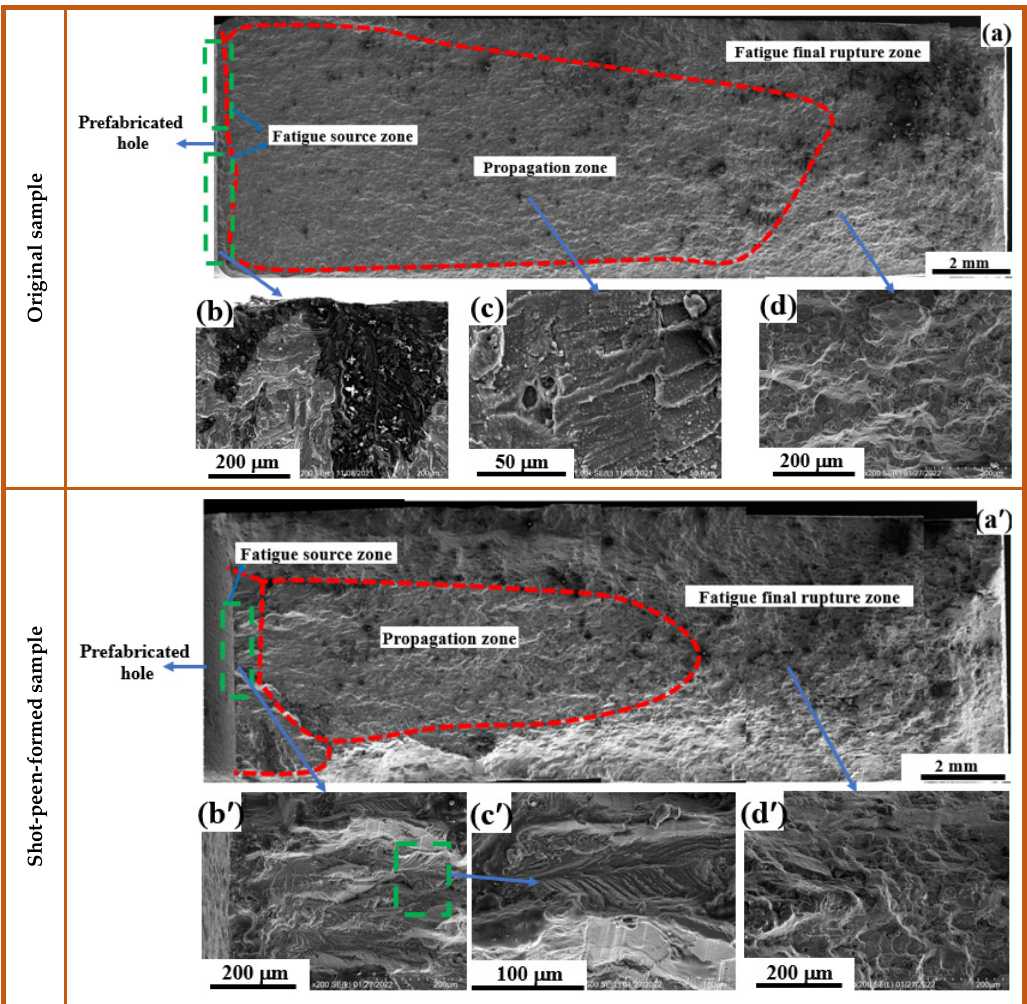
Figure 6. Fatigue fracture morphology of the ( a – d ) original and ( a ′ – d ′ ) shot-peen-formed samples in a salt-spray environment.